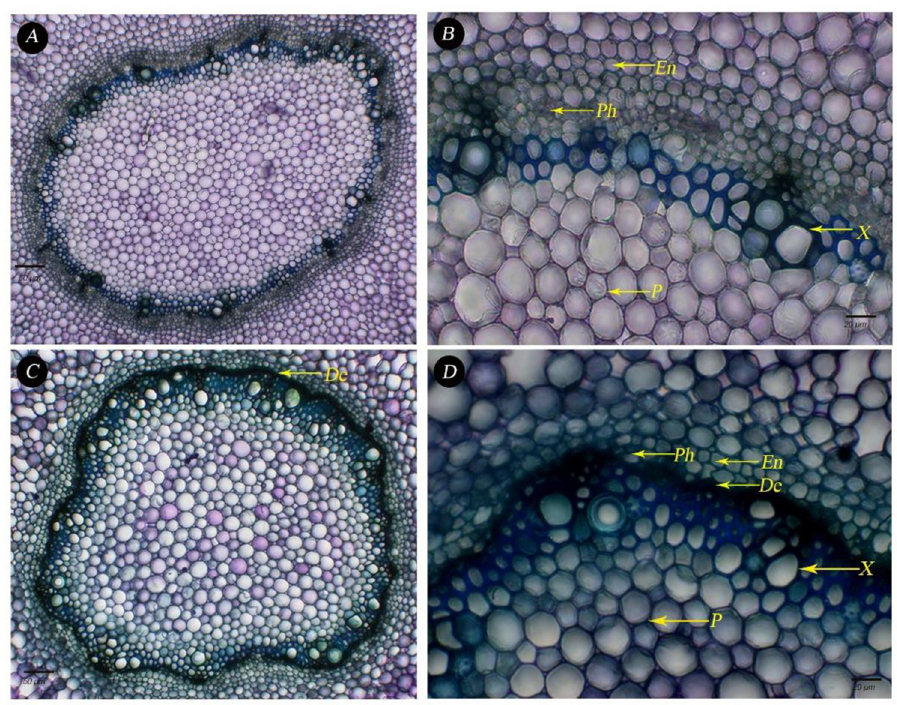
Fig 8. Changes in the root anatomy of A . ilicifolius L. subjected to ZnSO 4 (4 mM). A&B- Control C&D–Zn SO 4. En- Endodermis; X- Xylem; Ph-Phloem; P-Pith; De- Deposition.